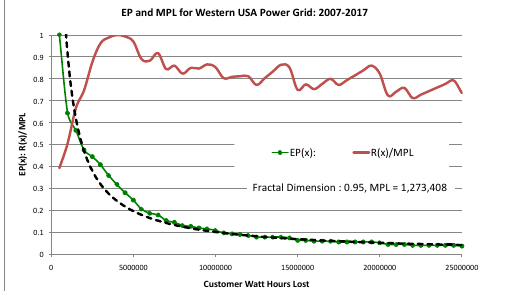
Figure 3. Illustrations of exceedance as a power law and risk derived from the exceedance probability curve. ( a ). US power grid risk versus consequence in terms of loss of kilowatt-hours of energy recorded over 10 years from 2007–2017. ( b ). Internet risk versus consequence in terms of breached sites recorded over 18 years from 2004–2022. The dotted line is the OLS fit to a power law.